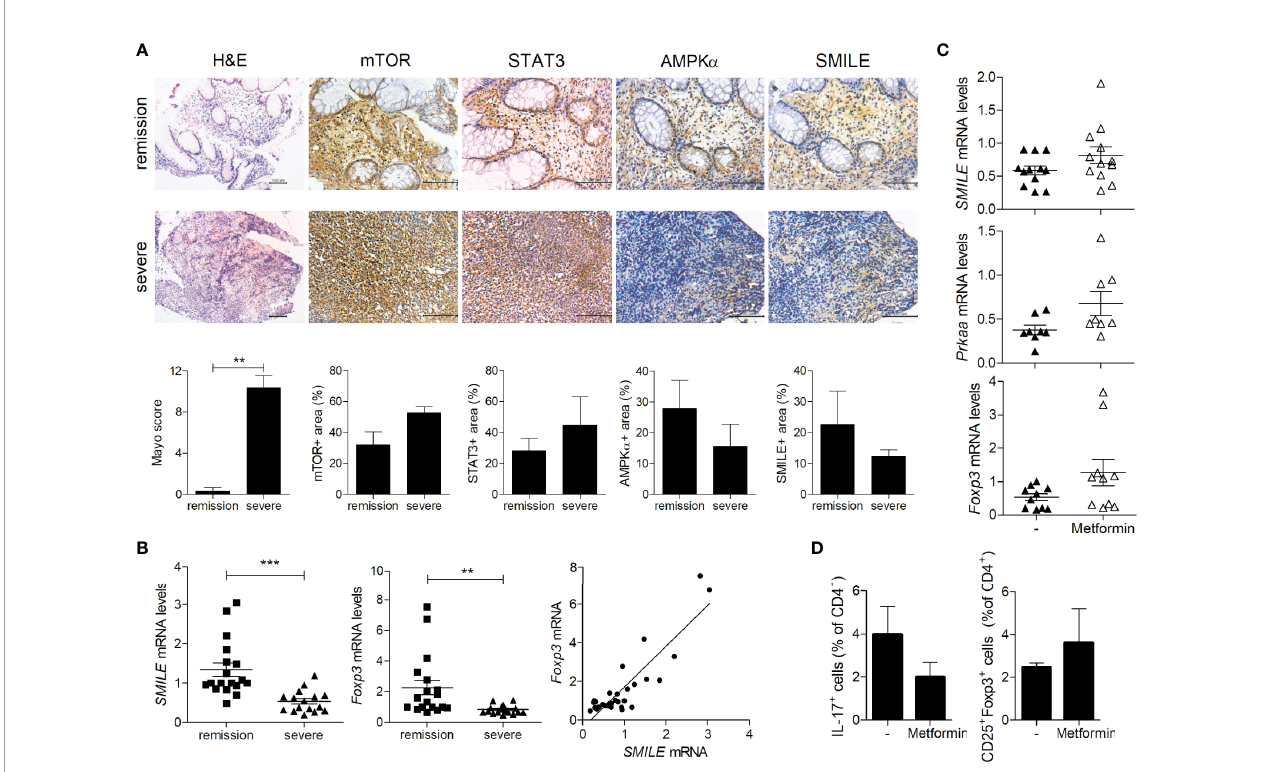
FIGURE 5 | Regulation of SMILE expression in the colon of patients with UC. (A) Colon tissues were evaluated by H&E staining and Mayo scoring. Representative images of IHC with anti-mTOR, -STAT3, -AMPK, and -SMILE antibodies. Bars are percentages of positive area per fi eld. (B) Fold changes in the SMILE and FOXP3 mRNA levels in UC PBMCs by real-time PCR (n = 9 per group). Correlation between SMILE and FOXP3 levels. (C) mRNA levels of SMILE, PRKAA, and FOXP3 in UC PBMCs treated with metformin (1 mM) for 48 h by real-time PCR. (D) Th17 and Treg cells in the PBMCs of metformin (1 mM)-treated patients with UC under Th17-polarizing condition for 72 h. Data are means±SEM. ** P < 0.01, *** P <